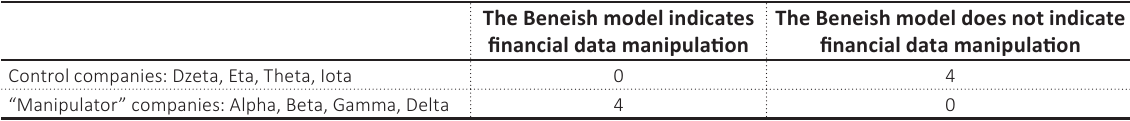
Table 7. Number of indications of the Beneish 8-factor model for “manipulator” and “non-manipulator”